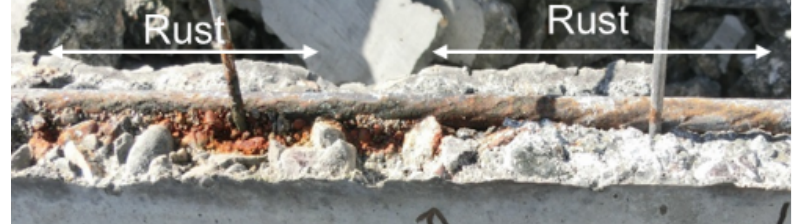
Figure 14. Observation of corrosion state of PC steel bar at the joint position of the concrete formwork during dismantling CP.